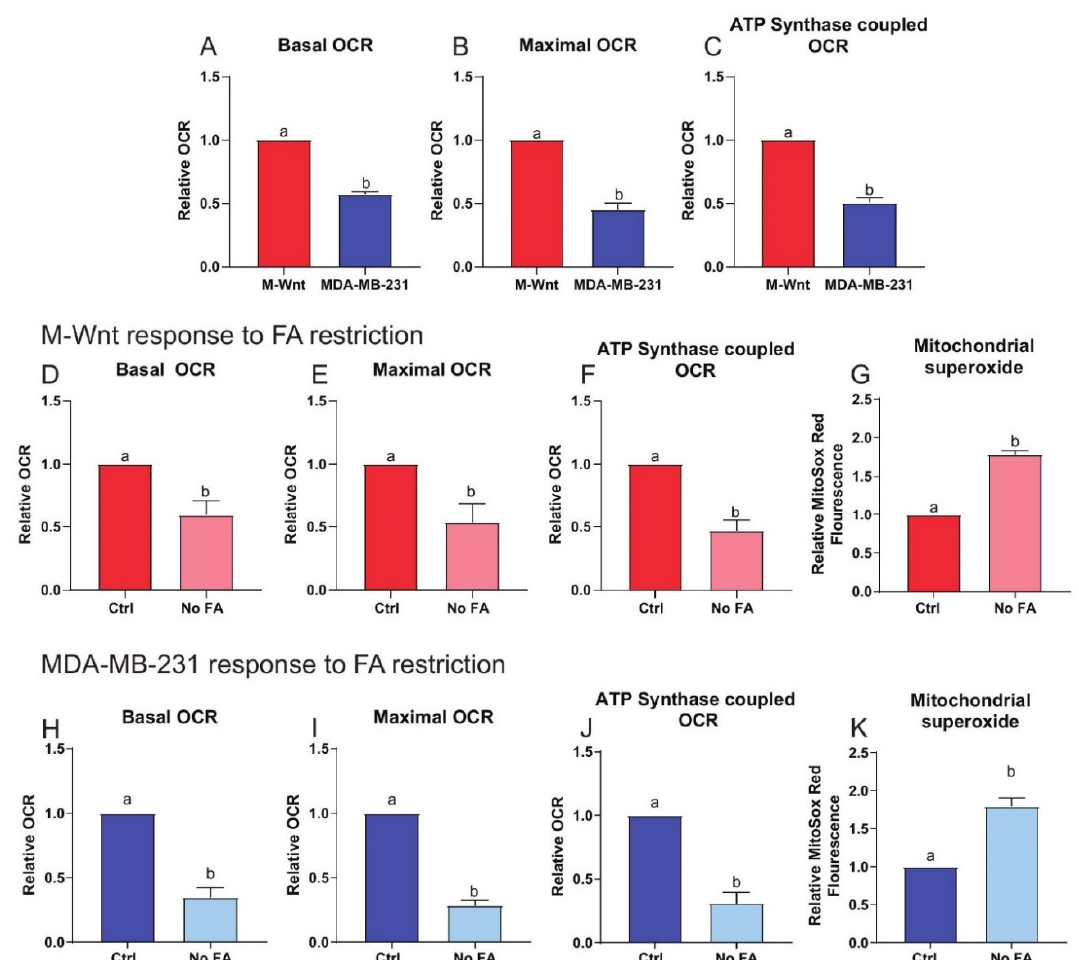
Figure 9. Innate mitochondrial dysfunction underpins response to FA restriction. Basal ( A ), maximal ( B ), and ATP synthase- coupled ( C ) OCR determined in M-Wnt cells and MDA-MB-231 cells (n = 3/group). Basal ( D ), maximal ( E ), and ATP synthase-coupled ( F ) OCR determined in M-Wnt cells following 3 weeks of culture with or without FA (n = 3/group). Mitochondrial superoxide production ( G ) determined using MitoSox Red in M-Wnt cells following 3 weeks of culture with or without FA (n = 3/group). Basal ( H ), maximal ( I ), and ATP synthase-coupled ( J ) OCR determined in MDA-MB-231 cells following 3 weeks of culture with or without FA (n = 3/group). Mitochondrial superoxide production ( K ) determined using MitoSox Red in MDA-MB-231 cells following 3 weeks of culture with or without FA (n = 3/group). Student’s t -test ( A – K ) used to determine significance ( p < 0.05), different letters indicate significant differences.